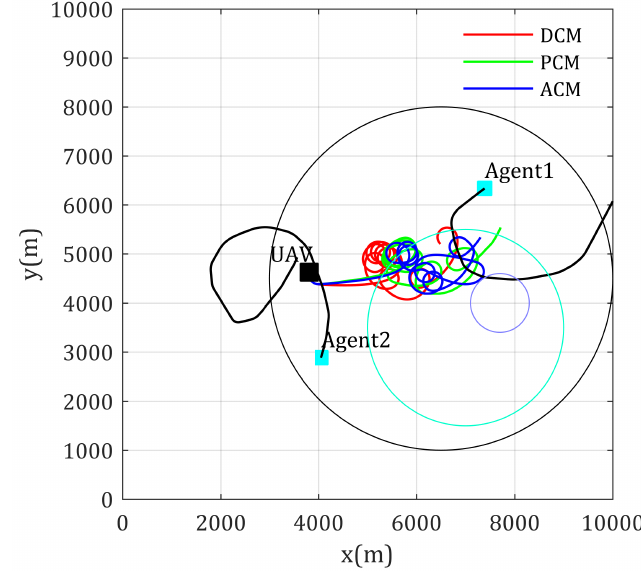
Figure 10. Paths for two mobile agents end-to-end communication with known channel